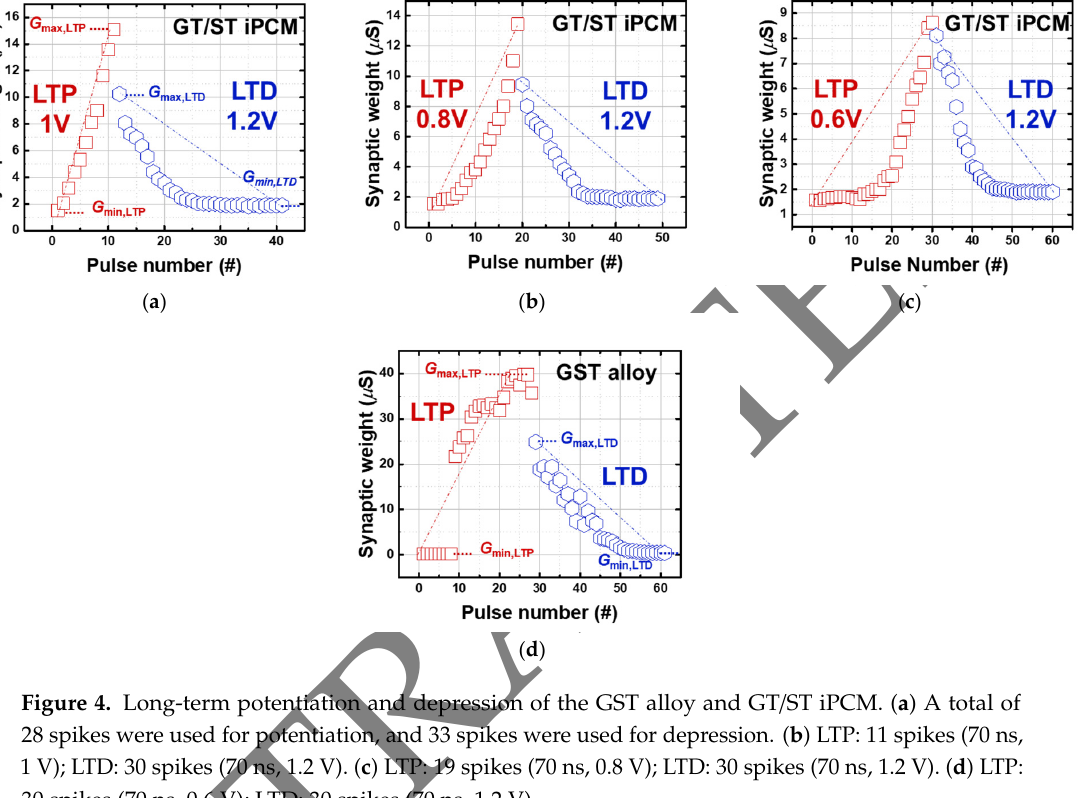
Figure 4. Long-term potentiation and depression of the GST alloy and GT/ST iPCM. ( a ) A total of 28 spikes were used for potentiation, and 33 spikes were used for depression. ( b ) LTP: 11 spikes (70 ns, 1 V); LTD: 30 spikes (70 ns, 1.2 V). ( c ) LTP: 19 spikes (70 ns, 0.8 V); LTD: 30 spikes (70 ns, 1.2 V). ( d ) LTP: